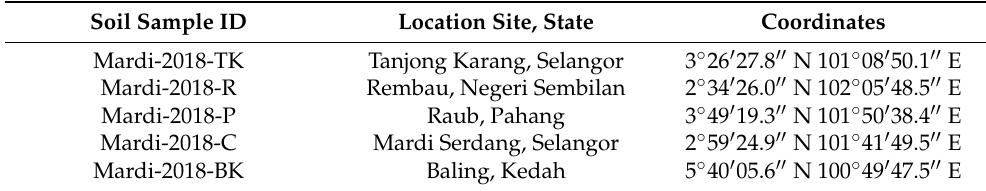
Table 1. Origin of the soil samples used for the isolation of the fungi identified in this study. The soil samples were collected from wild and cultivated healthy papaya populations in different states (Selangor, Negeri Sembilan, Pahang, and Kedah) of Peninsular Malaysia. Soil Sample